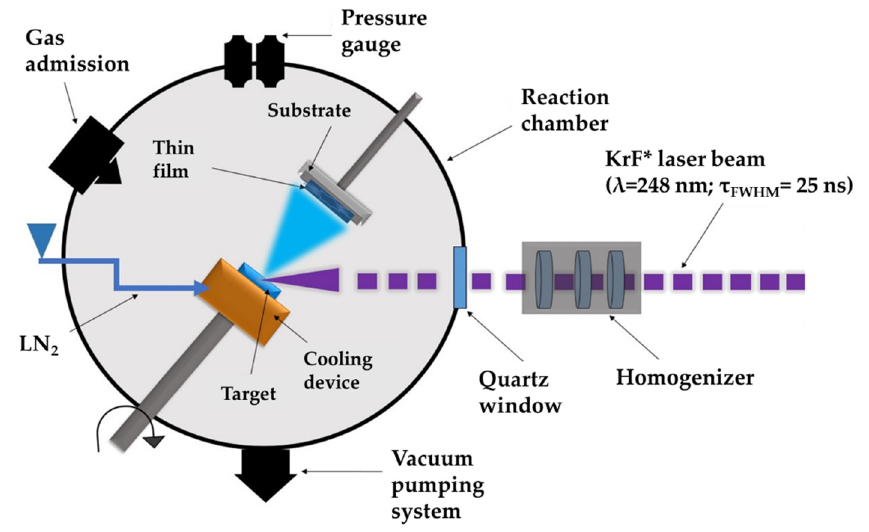
Figure 1. Schematic representation of MAPLE experimental set-up .